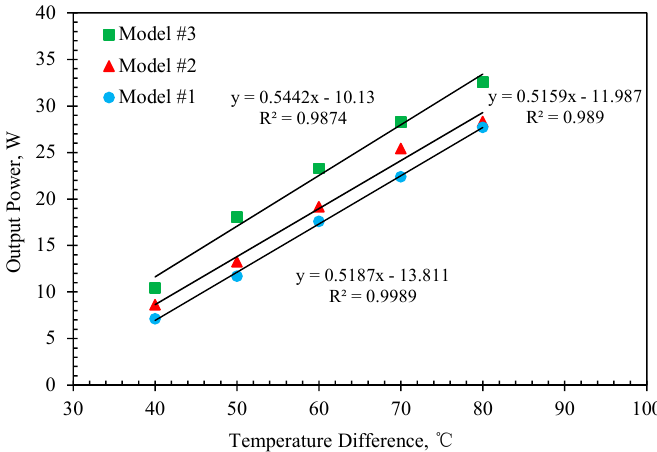
Figure 7. Relationship between ∆ T and maximum output power in different models.